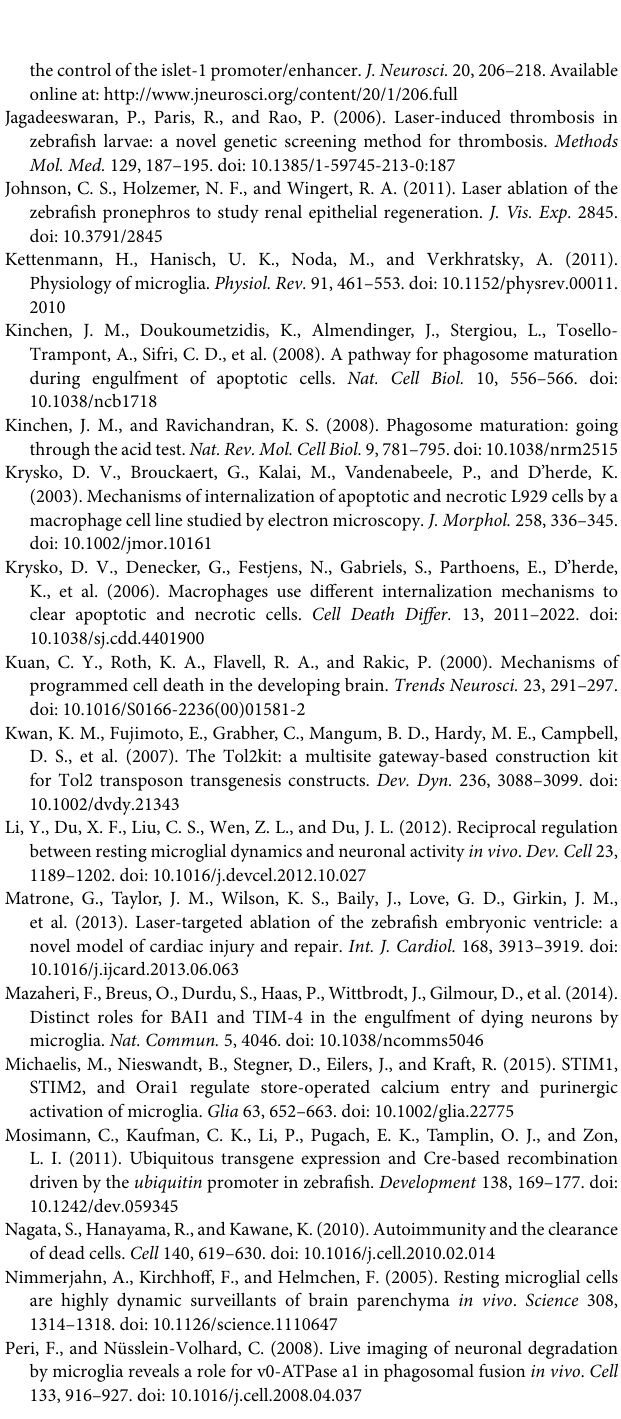
the photoconversion (red). Using a low laser power (A) results in focused Kaede photoconversion (from green to red fluorescence) limited to a single targeted neuron (upper row: lateral view; lower row: dorsal view). Higher laser power (B–D) results in radial diffusion of the UV laser of approximately 40–50 µ m. All laser ablation sites were conducted using a circular region of interest of ∼ 1.5 µ m in diameter, focused upon an individual soma of a neuron, with a laser dwell time of ∼ 60 seconds in each experiment. Scale bar = 20 µ